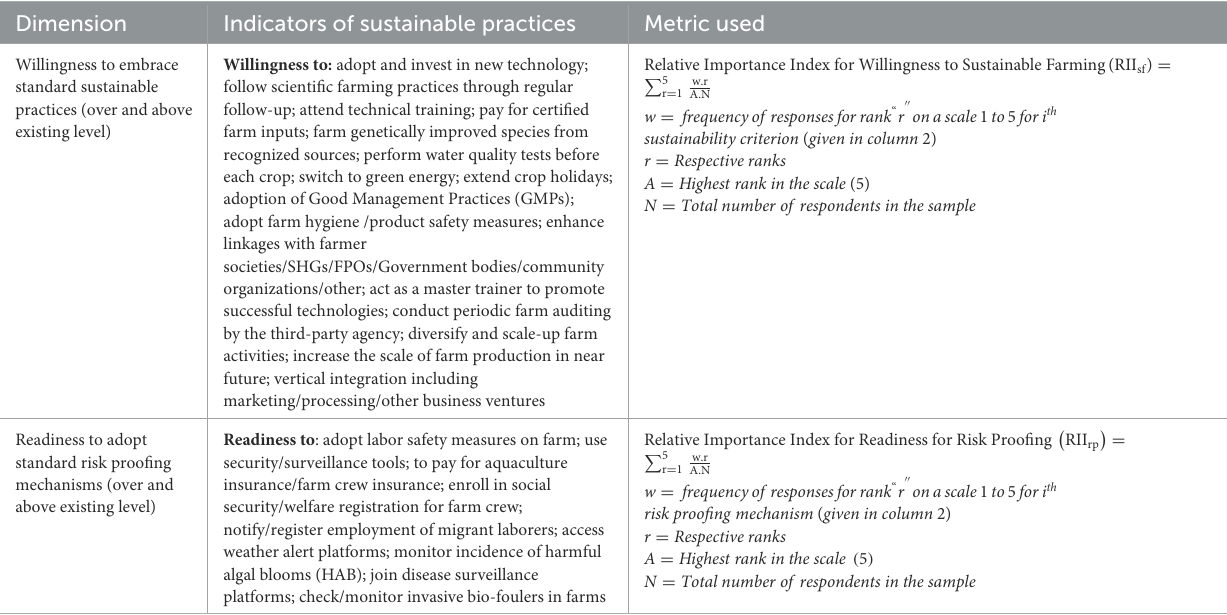
TABLE 2 Summary of key dimensions, criteria, and indicators as per PCI approach followed to assess future readiness of sample respondents for sustainable intensification of mariculture. Dimension Indicators of sustainable practices Metric